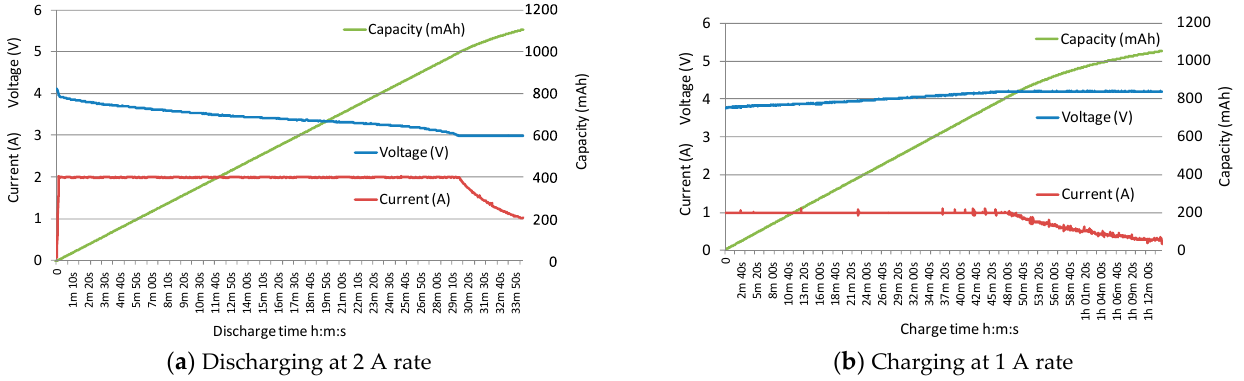
Figure 17. Comparison of discharge ( a ) and charge ( b ) current–voltage (C-V) characteristics of best performing cell, cell No. 21.